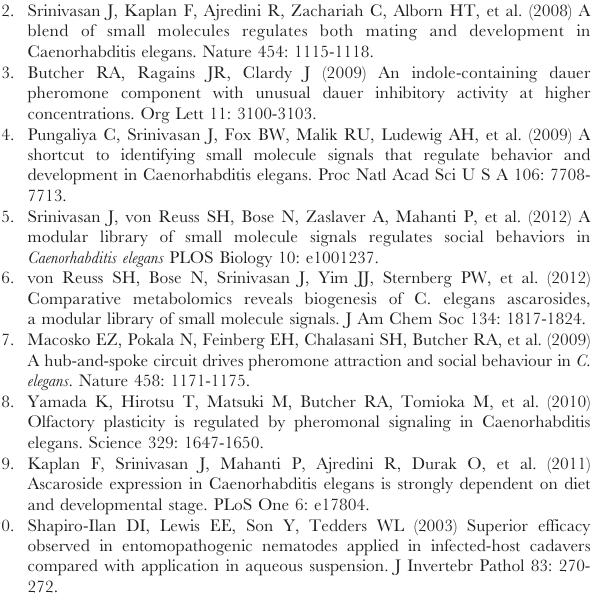
Figure S1 C. elegans dispersal blend, quantification and response of S. feltiae to C. elegans dispersal blend. (A), Structures of the ascarosides for the dispersal blend. (B), Quantification of dispersing C. elegans using Image J. Second column shows inverted pictures and the third column shows the counted nematodes. (C), Contribution of individual ascarosides to the activity of the synthetic blend. Ascr # 2, (3.68 pmol/ m l), ascr # 3 (0.165 pmol/ m l), ascr # 8 (0.25 pmol/ m l), and icas # 9 (0.005 pmol/ m l). Seven experiments were done for each treat- ment. + , present and 2 , absent. Student’s t-test, unpaired (p , 0.05). (D), S. feltiae response to C. elegans dispersal blend visualized within an entire plate. Figure S2 LC-MS ion chromatograms of fraction A. First panel shows ascr # 11 at m/z 279, second panel shows ascr # 9 at m/z 293. Figure S3 Ascr # 9 and ascr # 11 profile during S. feltiae development. For each time point, six insect cadavers were analyzed by LC-MS. For the 0 time point, 4 uninfected larvae were analyzed. * detected but not quantifiable.